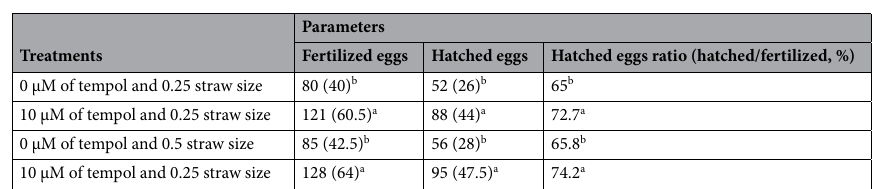
Table 7. Effect of tempol and straw size on fertility and hatchability rates of rooster semen after freeze- thawing. Each experimental group contained 200 eggs initially. Numbers are absolute counts of eggs, with percentages (ratio respect to the initial egg count) between parentheses, except for the hatched eggs ratio. Different superscripts letters within row are significantly different (P < 0.05).